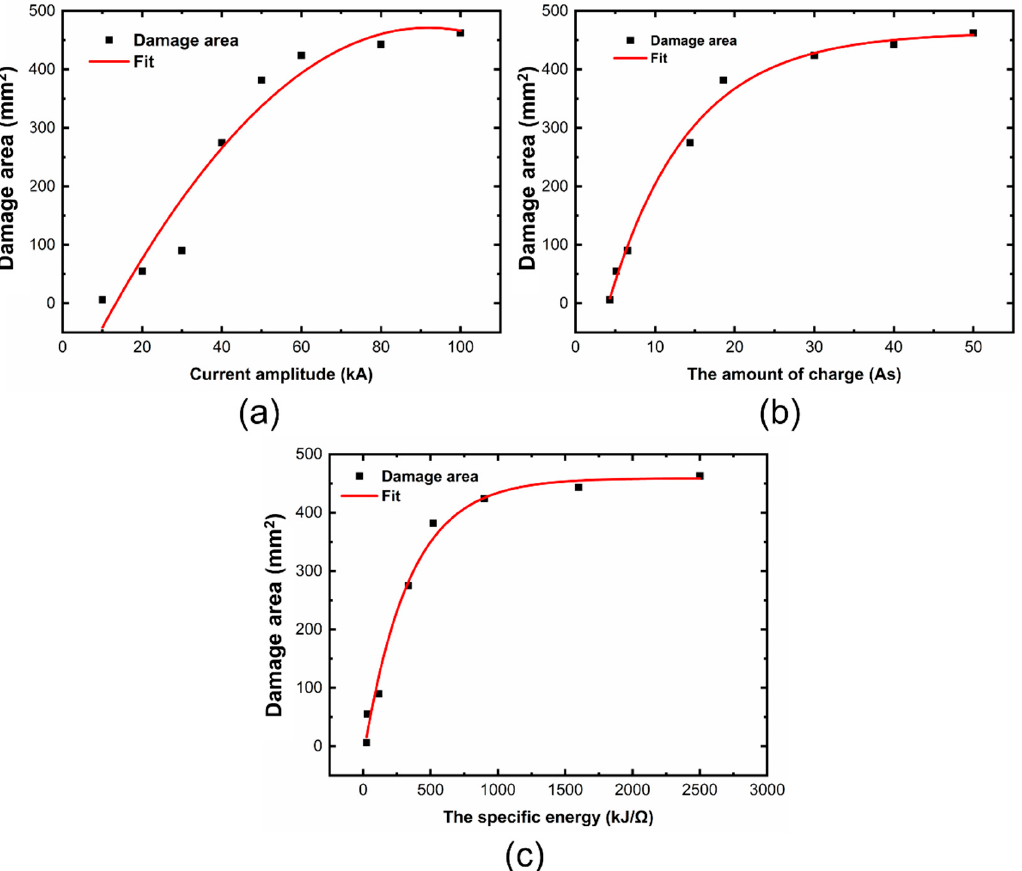
Figure 18. The relationship between GFRC creeping damage area and lightning current parameters, ( a ) damage area versus current amplitude curve, ( b ) damage area versus charge amount curve, ( c ) damage area versus specific energy curve.